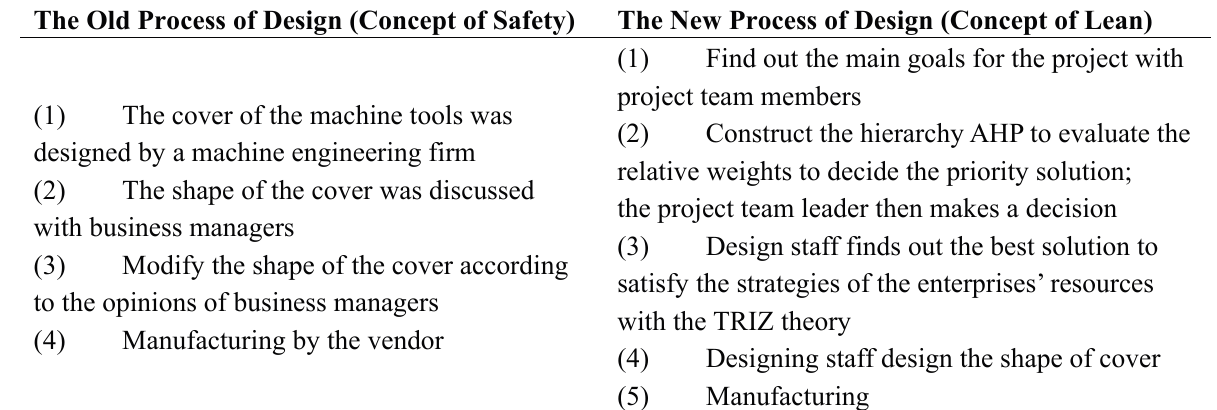
Table 3. The illustration of the process of